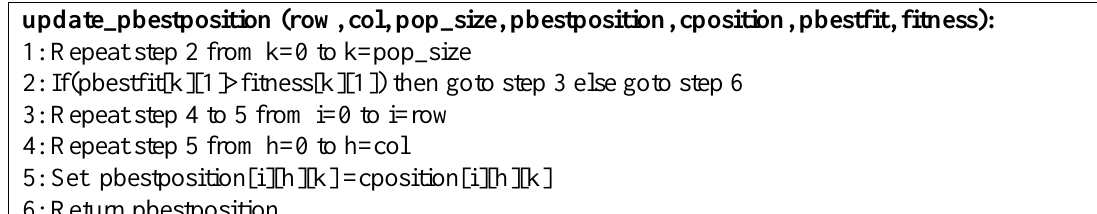
Algorithm 4. Function to update Pbest position of the particle